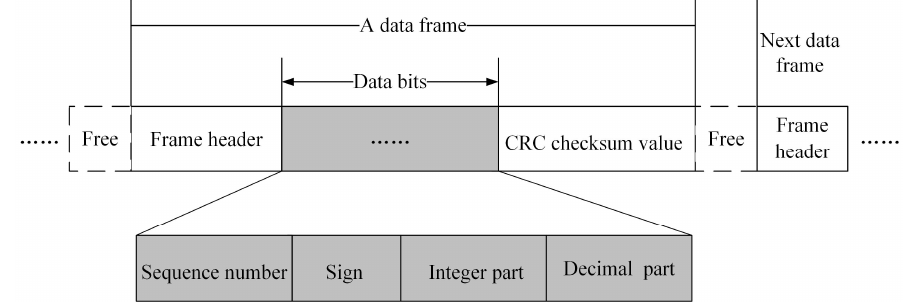
Figure 2. Data frame format.